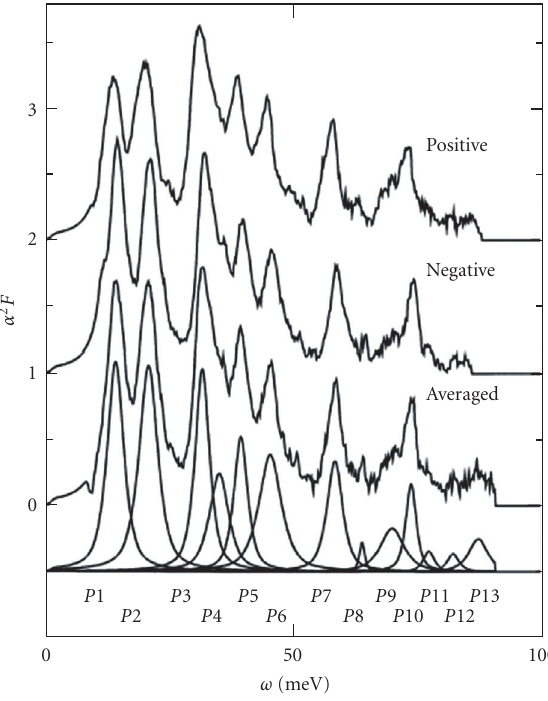
Figure 25: The phonon density of states F ( ω ) (PDOS) of Bi 2 Sr 2 CaCu 2 O 8 compared with the generalized density of states (GPDOS) [159]. Atomic vibrations: O1—O in the CuO 2 plane; O2—apical O; O3—O in the BiO plane. From [46,